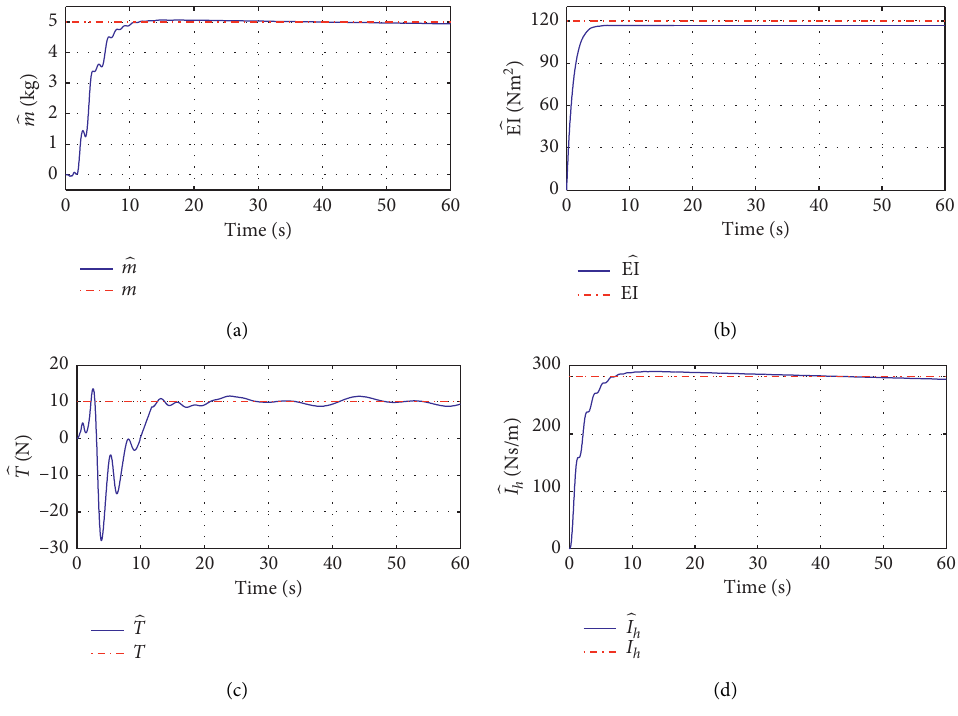
Figure 9: Estimates of system